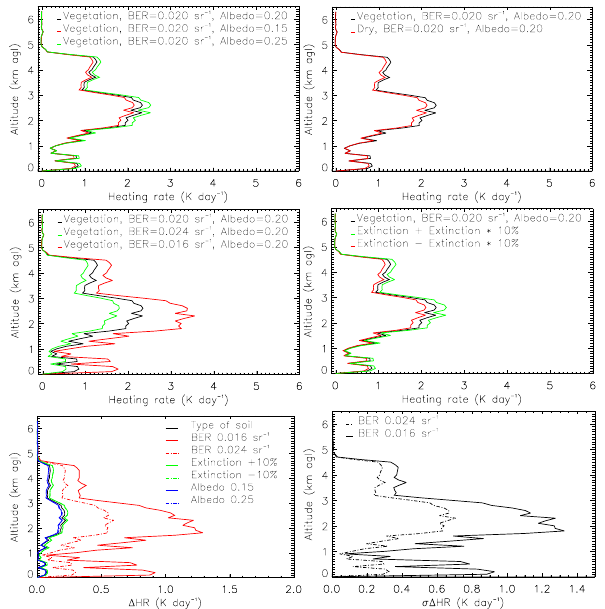
Fig. 9. Sensitivity of the LEANDRE-derived heating rate profile at 10 ◦ N on 14 June to: (a) surface albedo (b) type of soil, (c) dust BER and (d) lidar AEC. Uncertainties (in Kday − 1 ) for each of the previous variables are shown in (e) . Uncertainties are computed with respect to reference profile shown in Fig. 7a and using the RaCH model. The total uncertainty on the HR, taken as the sum of the quadratic errors of all variable previously shown are shown in (f) : the dashed line corresponds to the minimum total uncertainty and the solid line corresponds to the maximum total uncertainty (see text for